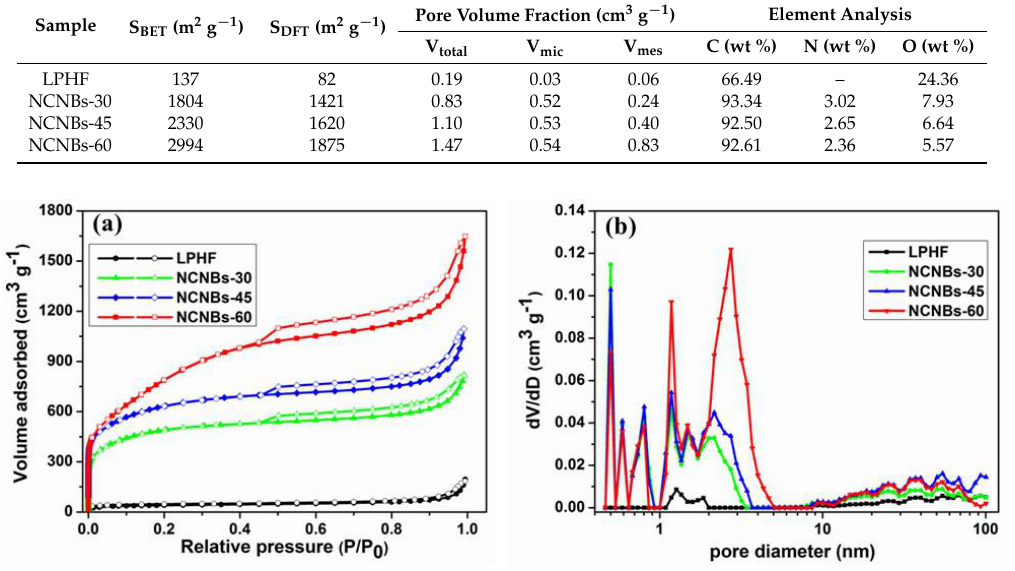
Figure 5. ( a ) Nitrogen adsorption-desorption isotherms and the pore size distribution curves ( b ) all of the as-prepared NCNBs.